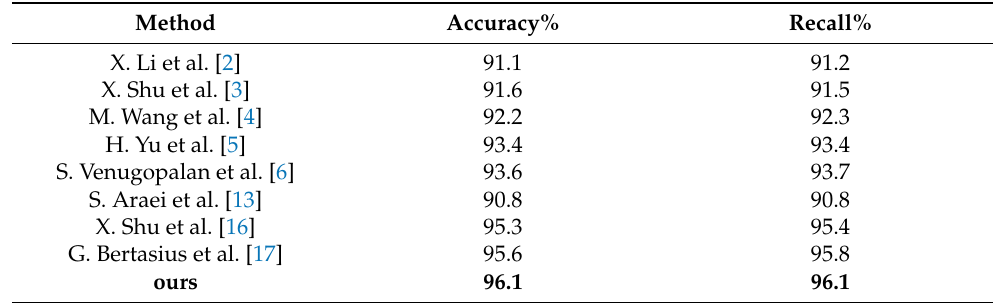
Table 2. Comparison of pedestrian activity detection